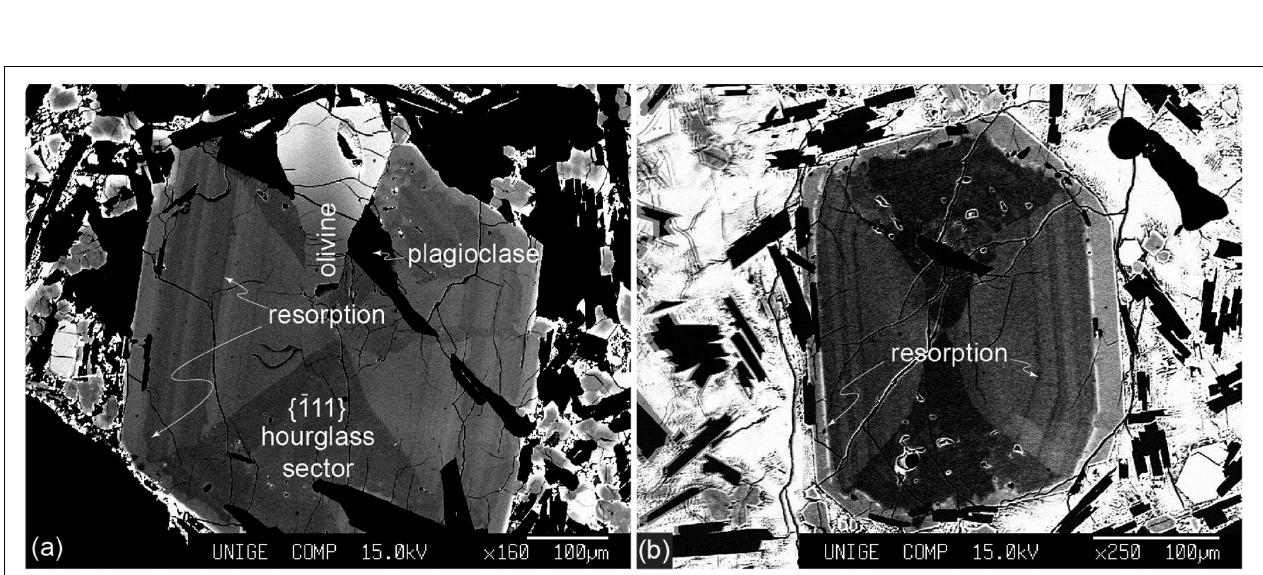
FIGURE 2 | SEM- Backscattered images of two selected clinopyroxenes. Both crystals show hourglass sector zoning, oscillatory zoning (pervasive also through the hourglass zone) and a relatively bright outer rim. (a) The crystals present two main regions of resorption, inclusions of plagioclase and a chemically zoned olivine crystal. (b) This crystal shows an example of a very bright growth region toward the outer portions of the crystal, which we observed in a small proportion of cpx. This rim invariably presents an irregular outer boundary.